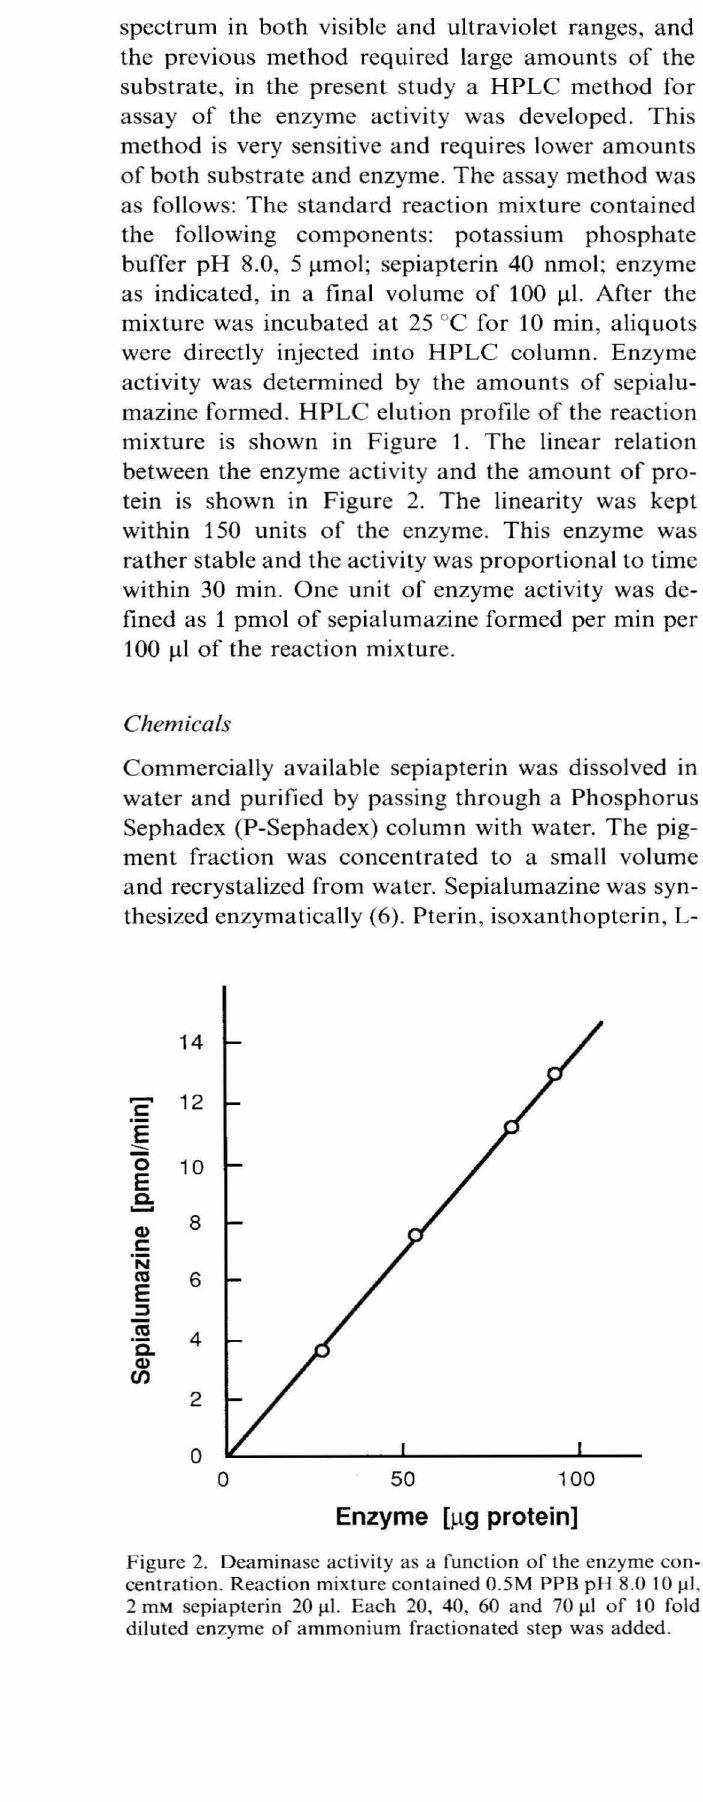
Figure 2. Deaminase activity as a function of the enzyme con centration. Reaction mixture contained O.SM PPB pH 8.0 10 Ill, 2 mM sepiapterin 20 Ill. Each 20, 40, 60 and 70 III of 10 fold diluted enzyme of ammonium fractionated step was